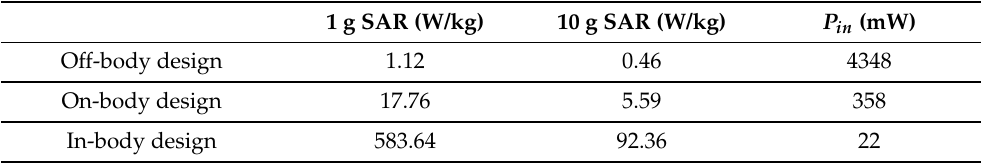
Table 3. Simulated maximum SAR value for 1 W antenna input power averaged per 1 g and 10 g